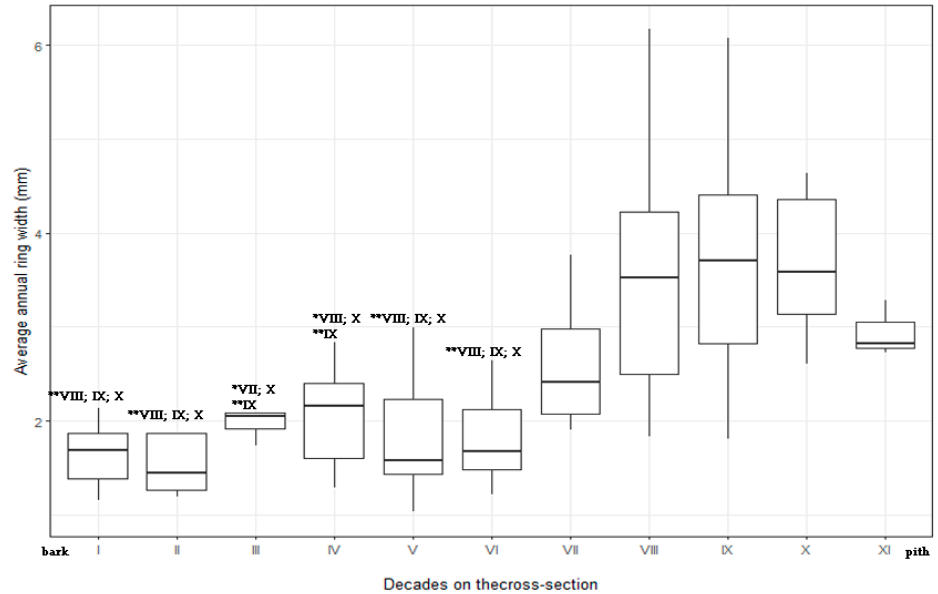
Figure 5. Changes of average annual ring width (mm) on cross-section of the trunk from bark (sec- tion I) to pith (sections X/XI) with marked * significant and ** highly significant differences between wood samples using HSD Tukey test. Description: whiskers represent minimum and maximum values, boxes—1st and 3rd quartile values, midlines—median.